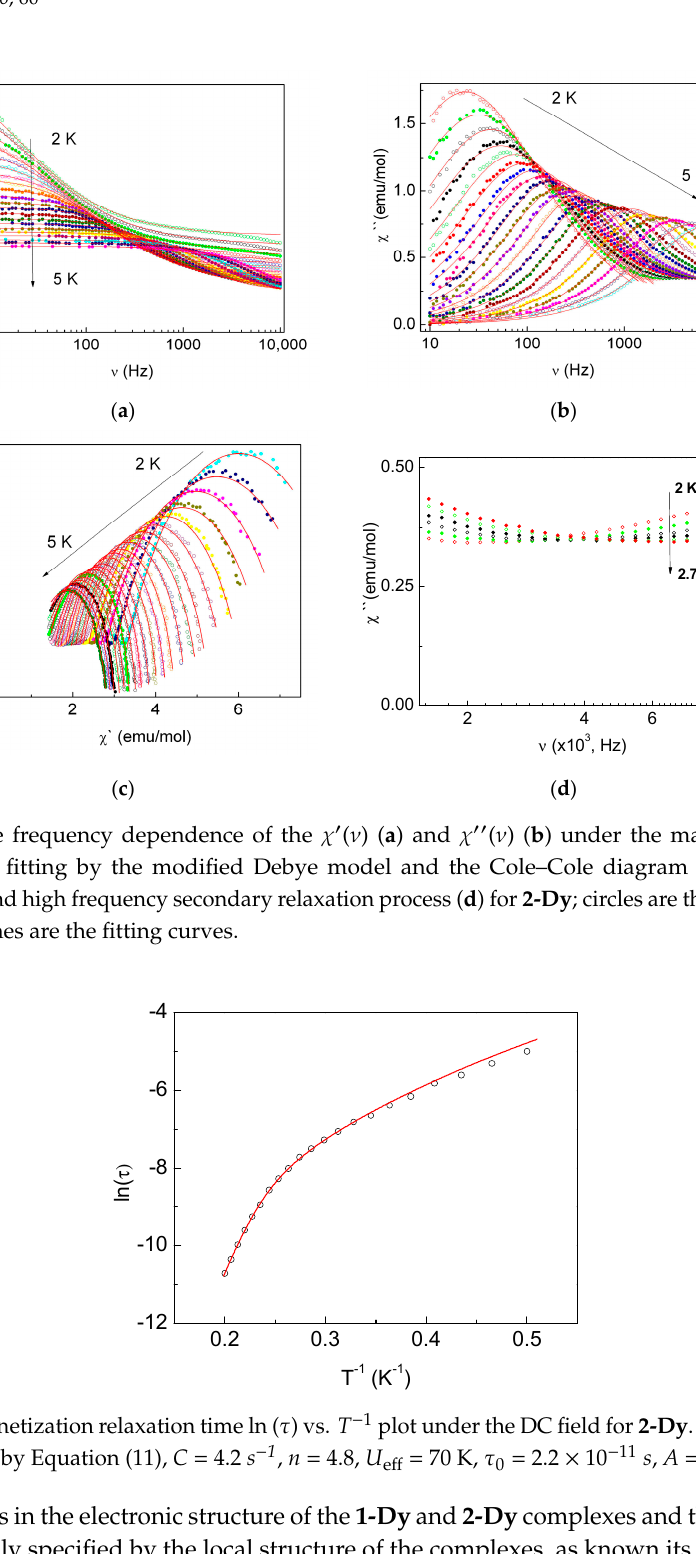
Figure 12. Magnetization relaxation time ln ( τ ) vs. T − 1 plot under the DC field for 2-Dy . The solid is the best fitting plot by Equation (11), C = 4.2 s − 1 , n = 4.8, U eff = 70 K, τ 0 = 2.2 × 10 − 11 s , A = 0, τ QTM − 1 = 0.